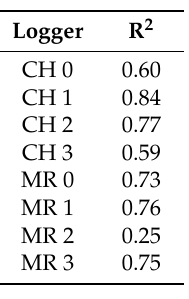
Table 3. Linear regression between water level peak and turbidity peak.